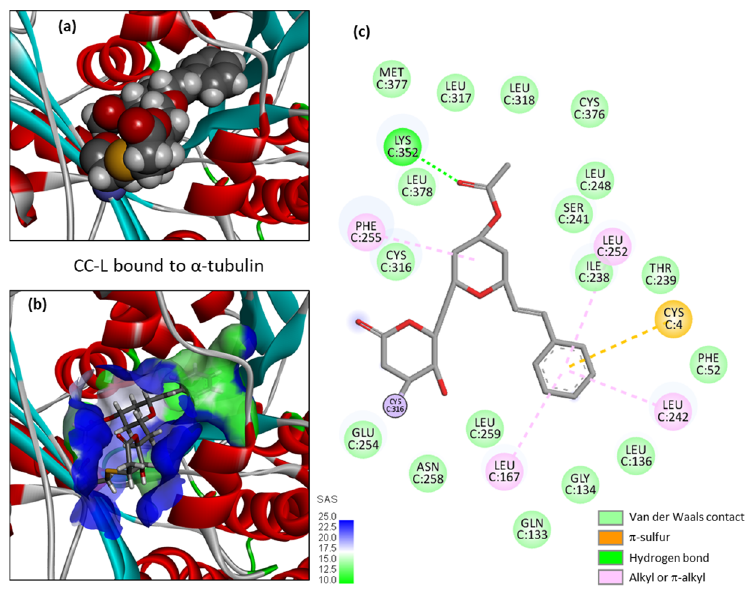
Figure 5. The molecular model of cryptoconcatone L (CC-L) bound to α -tubulin. ( a ) A space-filling (CPK) model of the drug covalently bound to the protein. ( b ) A close-up view of CC-L inserted into the binding cavity, with the solvent-accessible surface (SAS) surrounding the drug binding zone (color code indicated). A ribbon model of α -tubulin is shown, with α -helices (in red) and β -sheets (in cyan). ( c ) Binding map contacts for CC-L bound to α -tubulin (color code indicated).